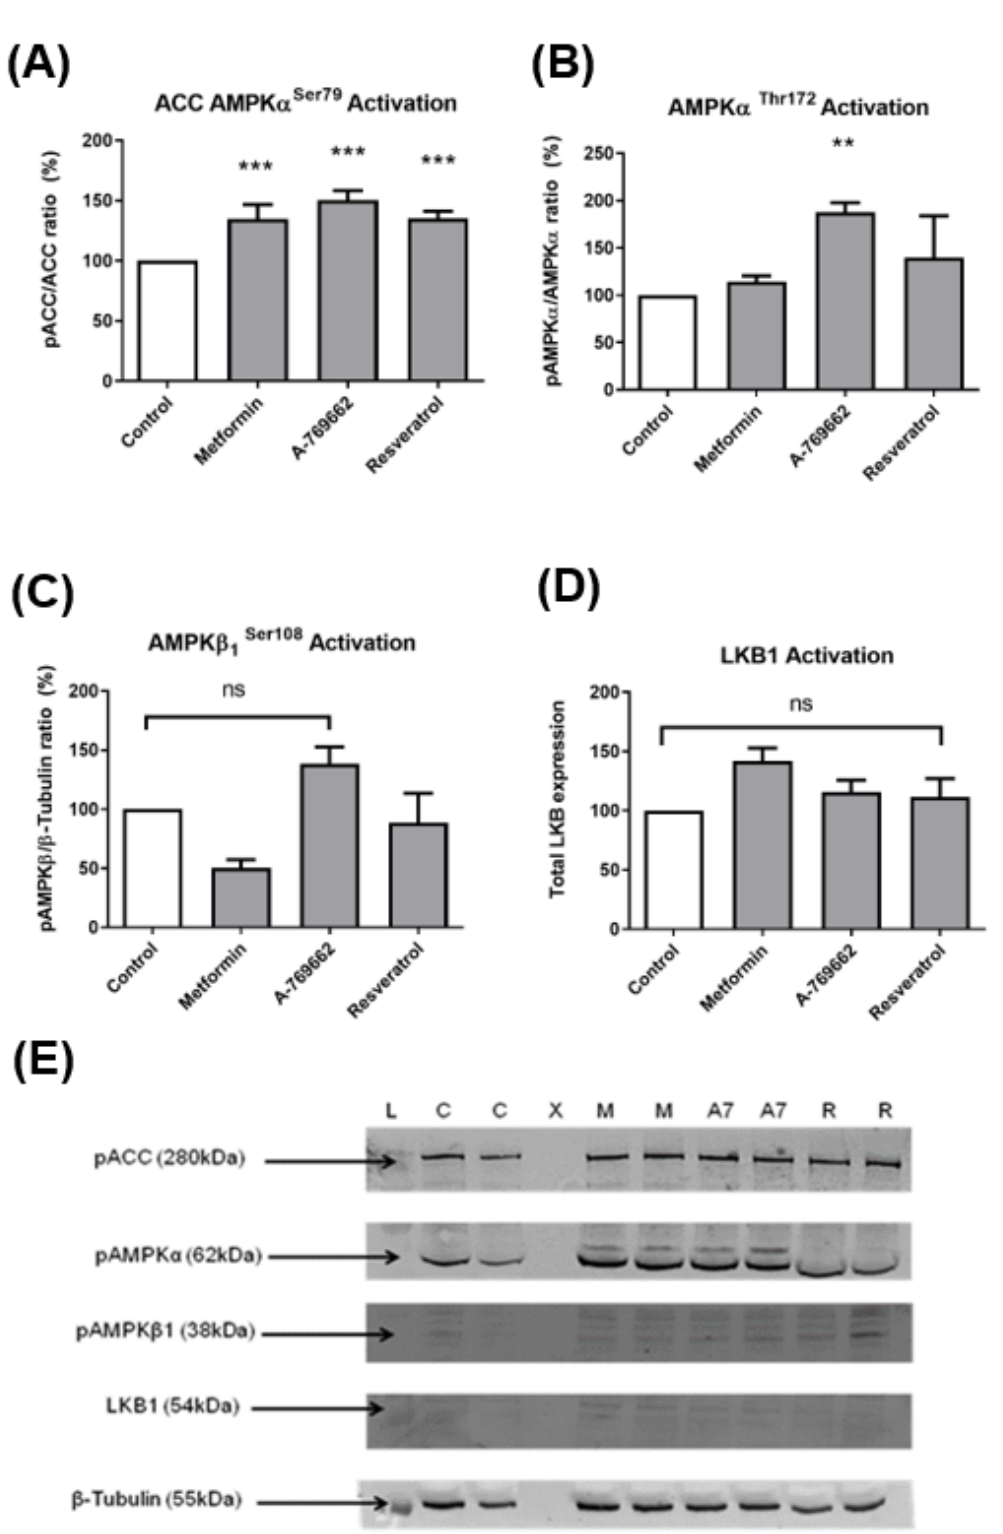
Figure 2. ( A – D ) Representative Western blot and quantification of pACC ser79, pAMPK α , pAMPK β 1, and LKB1 normalised to β -tubulin after a selection of drug treatments: protein ladder (L), no treatment control (C), blank X, metformin (M), A769662 (A7), resveratrol (R); ( E ) Western blots were quantified using LICOR technology (one-way ANOVA with Dunnett’s post hoc test ( n = 4) ** p ≤ 0.01 vs. control. ** p ≤ 0.001 vs. control.